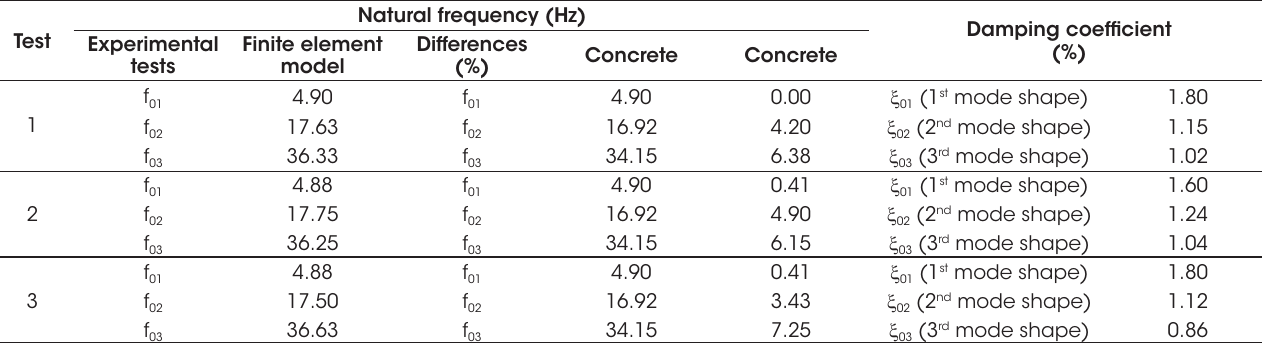
Modal analysis tests and numerical